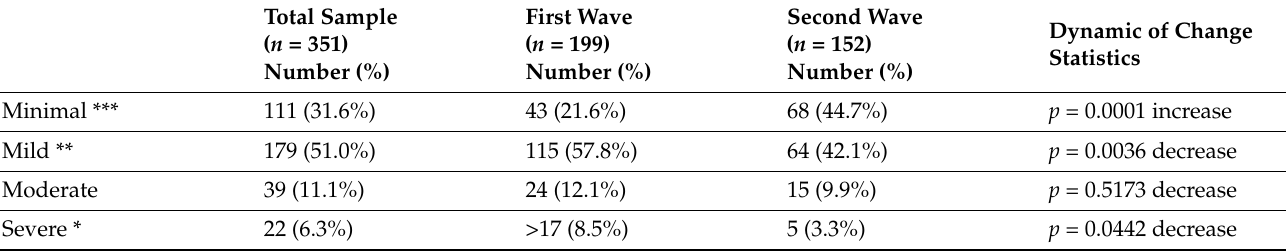
Table 5. Specific GAD-7 scoring